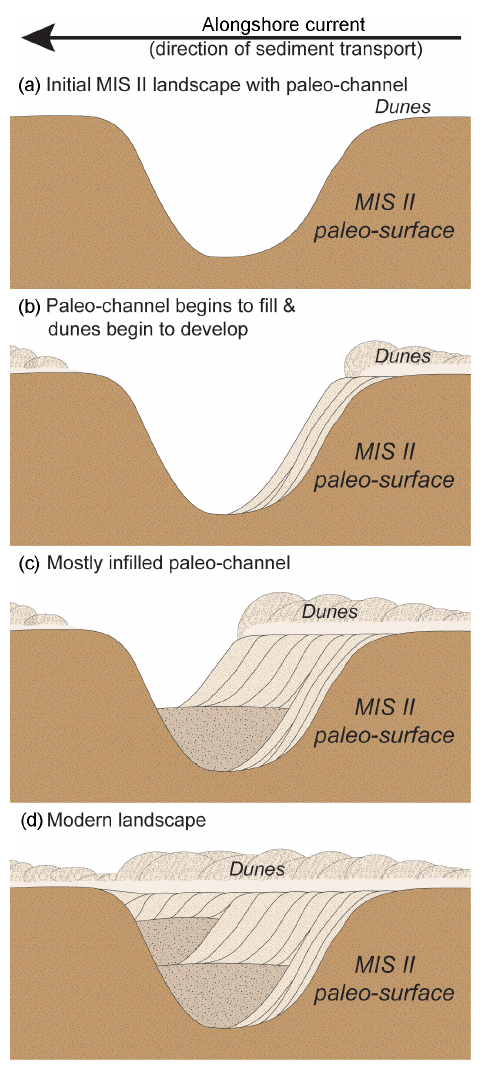
Figure 7. The stages of how paleo-channels in the framework geol- ogy affected barrier island development and evolution at PAIS, be- ginning with (a) initial paleo-channel incision (approximately MIS II). (b) As sea-level began to rise, sediment was transported south from river outlets to the north and was deposited along the north- ern edge of the paleo-channel. (c) Continued sea-level rise and sed- imentation from the north, coupled with episodic fluvial channel fill, continue to fill the paleo-channel until (d) the paleo-channel is completely infilled and the island coalesces alongshore. From (a) to (d) beaches to the north of the active channel area are supplied with sediment from river outlets up-drift, which provide ample sediment supply for aeolian sediment transport and dune